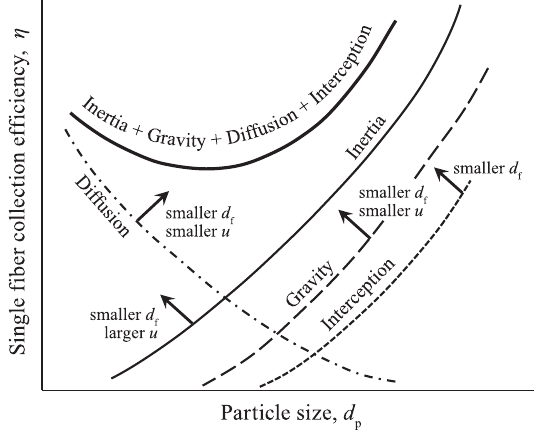
(11) Fig. 1 Effect of fiber diameter on single fiber collection effi -